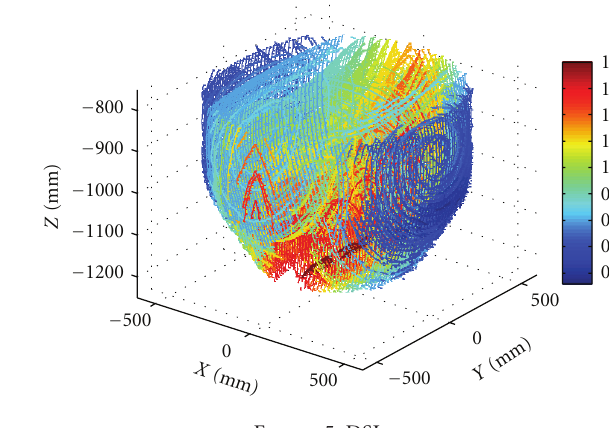
Figure 5: DSI μ X